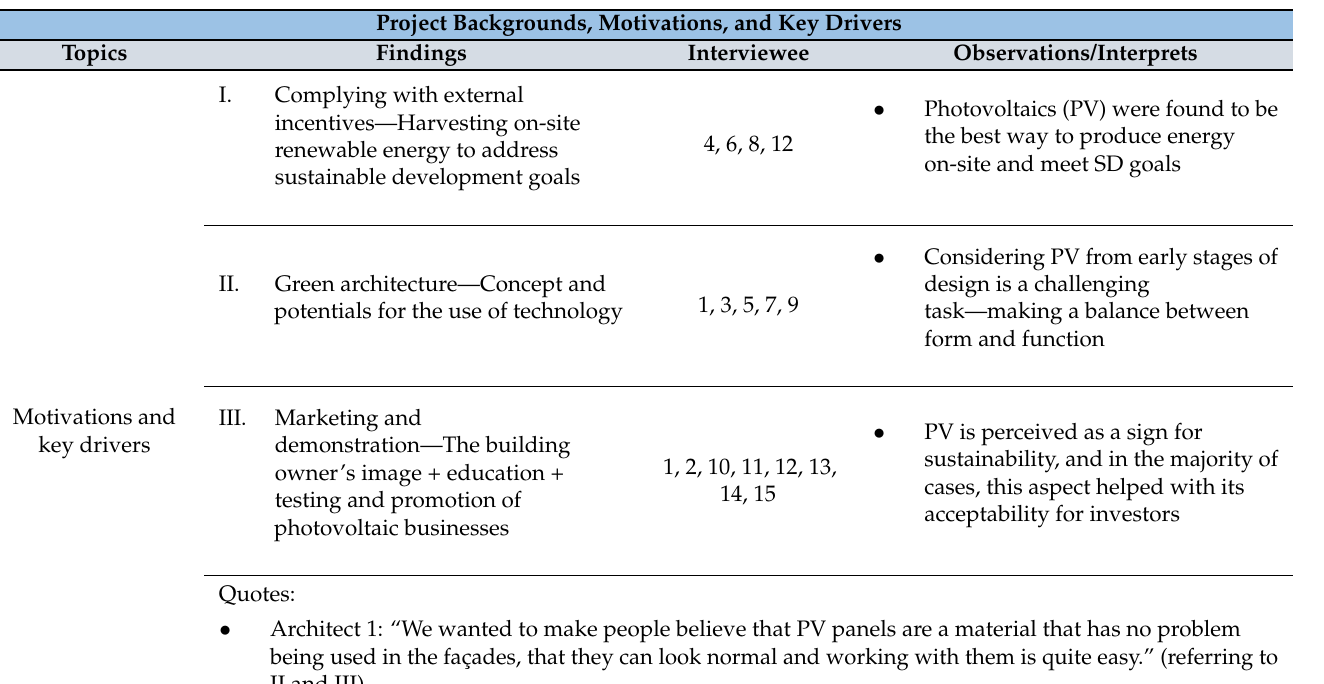
Table 1. Experiences and lessons